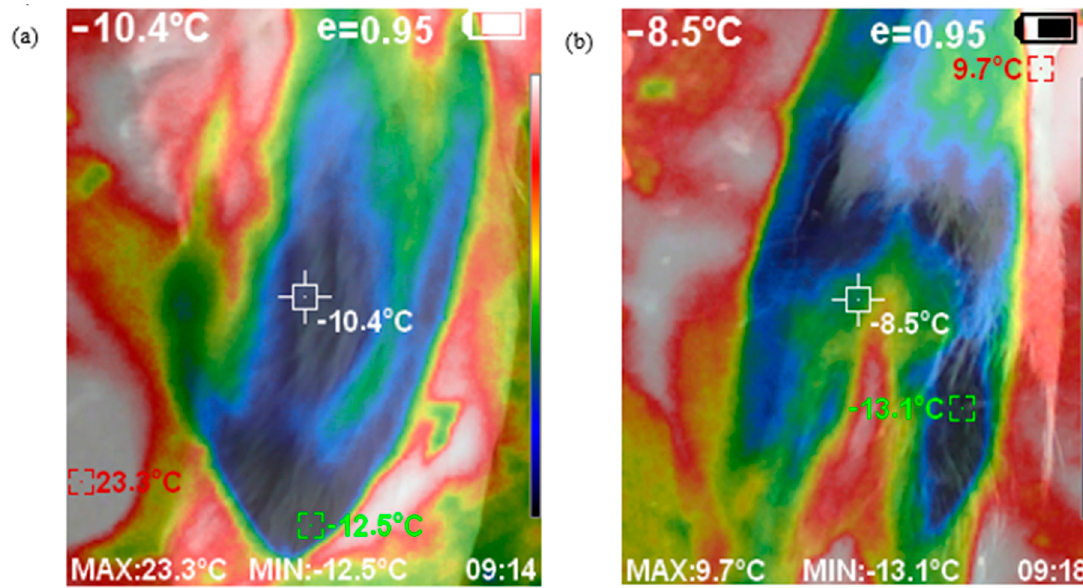
Figure 1. Example ofrainbow colour palette of front-on view thermograms of a sheep’s ear ( a ) and foot ( b ). Measured variables, outlined by the square, where the red is maximum temperature, green minimum temperature and white is the centre point of the camera IRT. The coloured index depicted temperatures from hot to cold using the colours white, red, yellow, green and blue.